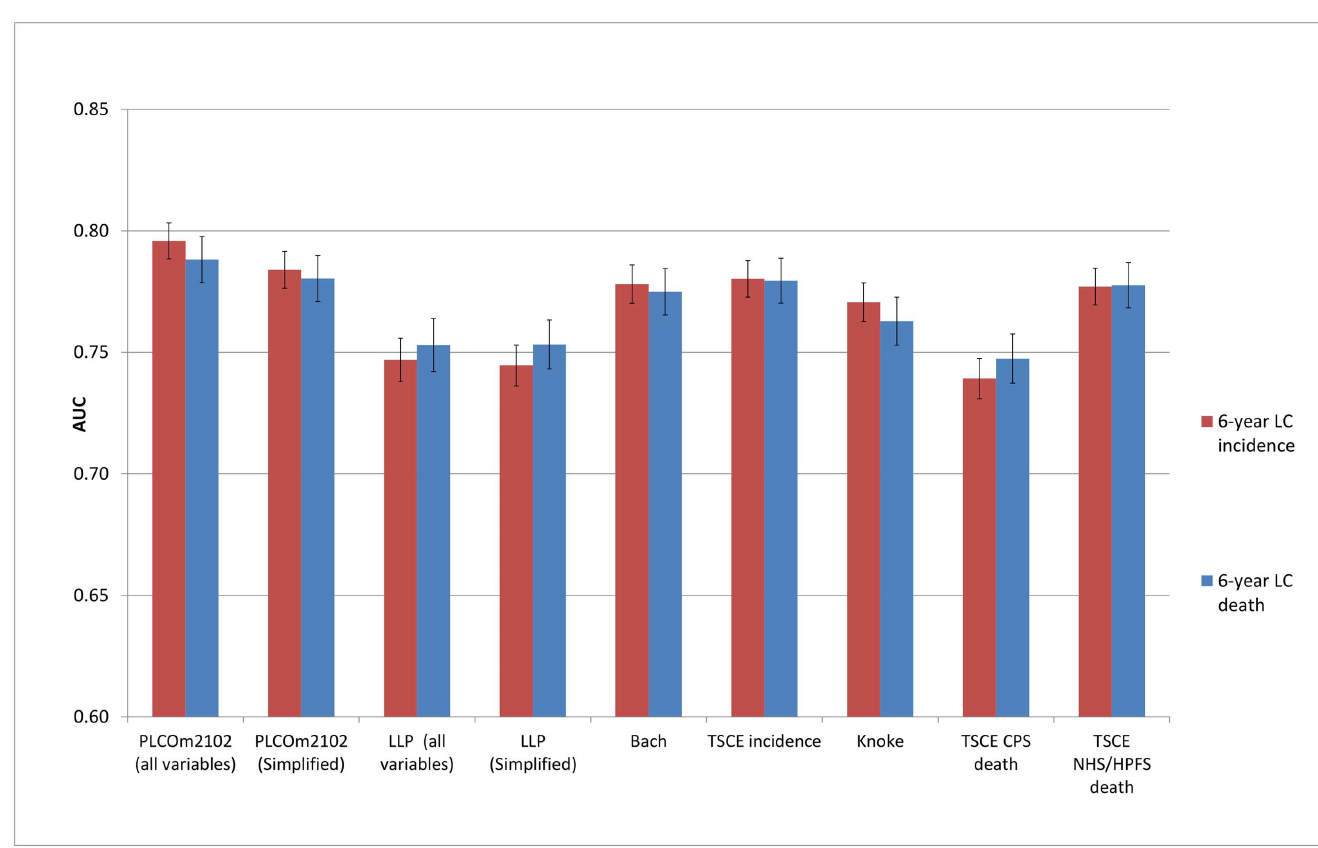
Fig 5. Area under the receiveroperating characteristic curve of the investigated risk models (with 95% confidence interval) in the Prostate, Lung, Colorectal and Ovarian Cancer Screening Trial control arm by predicted outcome. AUC, area under the receiver operating characteristic curve; CPS, Cancer Prevention Study; HPFS, Health Professionals Follow-upStudy; LC, lung cancer; LLP, Liverpool LungProject; NHS, Nurses’ Health Study; TSCE, Two-Stage Clonal Expansion.